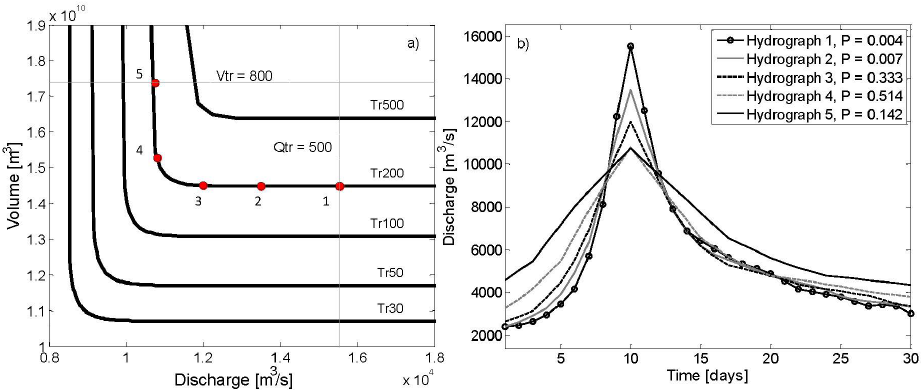
Fig. 5. Bivariate analysis: (a) level curves for the Gumbel copula for different return periods (black lines) and ( q , v ) pairs adopted for the 200yr event (red dots); (b) flow hydrographs corresponding to copula-based ( Q , V ) pairs.